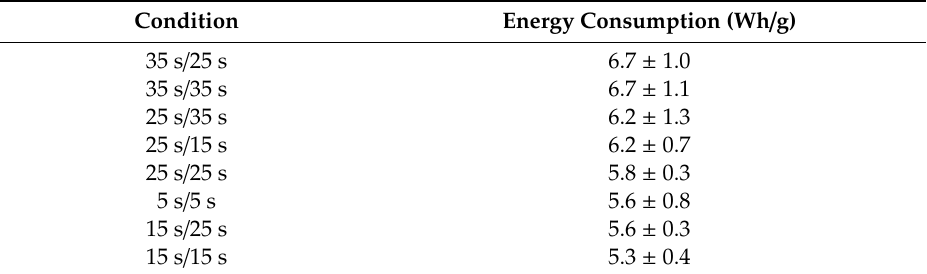
Table 2. Relative energy consumption for the eight PEF conditions after 3 hours of effective current application during the ED treatment of acid whey.